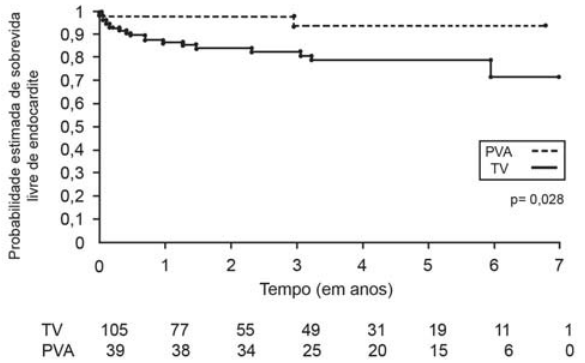
Fig. 5 - Curvas de sobrevida livre de endocardite dos pacientes submetidos à reconstrução da raiz da aorta com o tubo valvulado (TV) e com a preservação da valva aórtica (PVA), durante o período de sete anos de